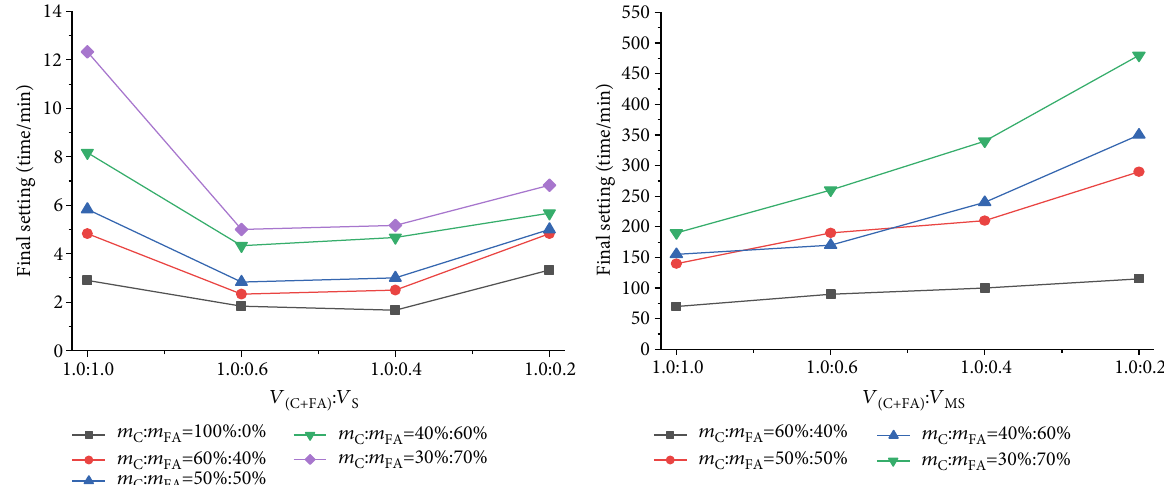
Figure 2: Curves of the fi nal setting time. Note: m ratio of the C-FA slurry to the pure S solution, and V ð